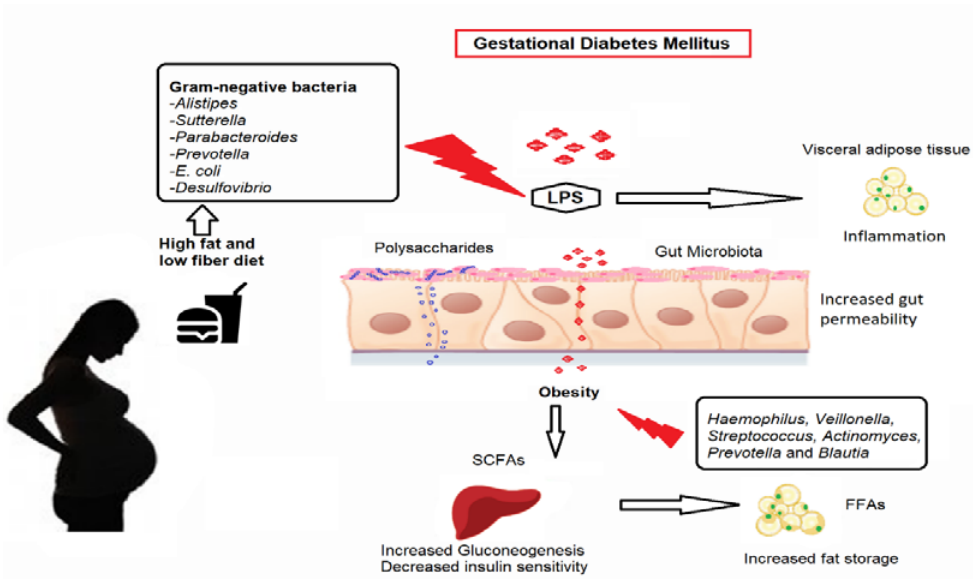
Figure 2. Potential mechanisms of pathobiont adherence and efflux through the gut epithelium in GDM women. LPS, lipopolysaccharides; FFAs, free fatty acids; SCFAs, short-chain fatty acids. Note: Images were obtained separately